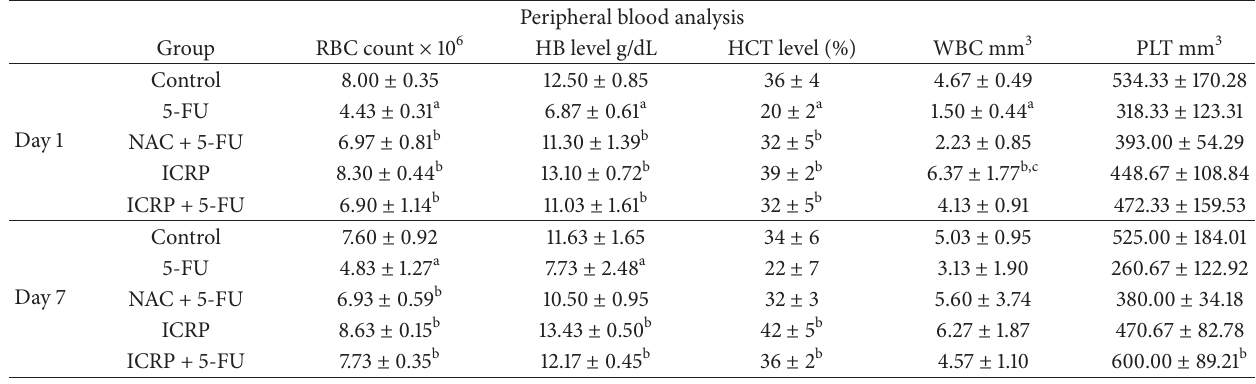
Table 3: Effects of 5-FU, NAC + 5-FU, ICRP, and ICRP + 5-FU on peripheral blood analysis in treated mice.